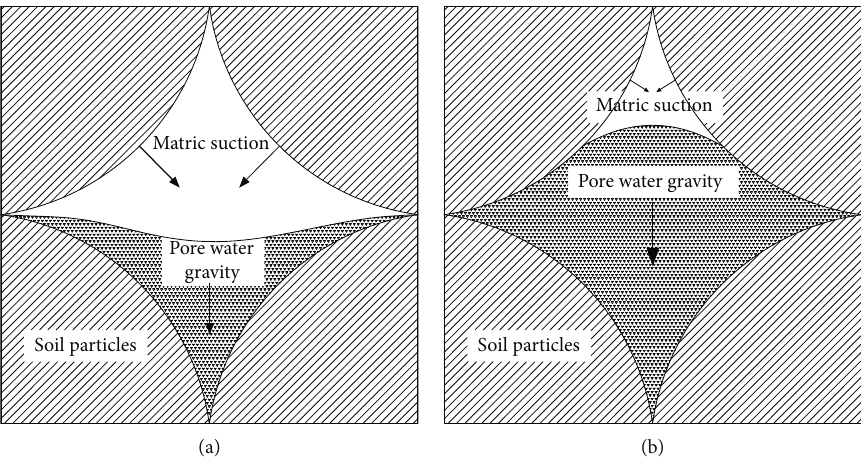
Figure 1: Pore water pressure and pore water gravity in unsaturated soils changing with saturation. (a) The pore water gravity is small, and the matrix suction is large. (b) The pore water gravity is large, and the matrix suction is